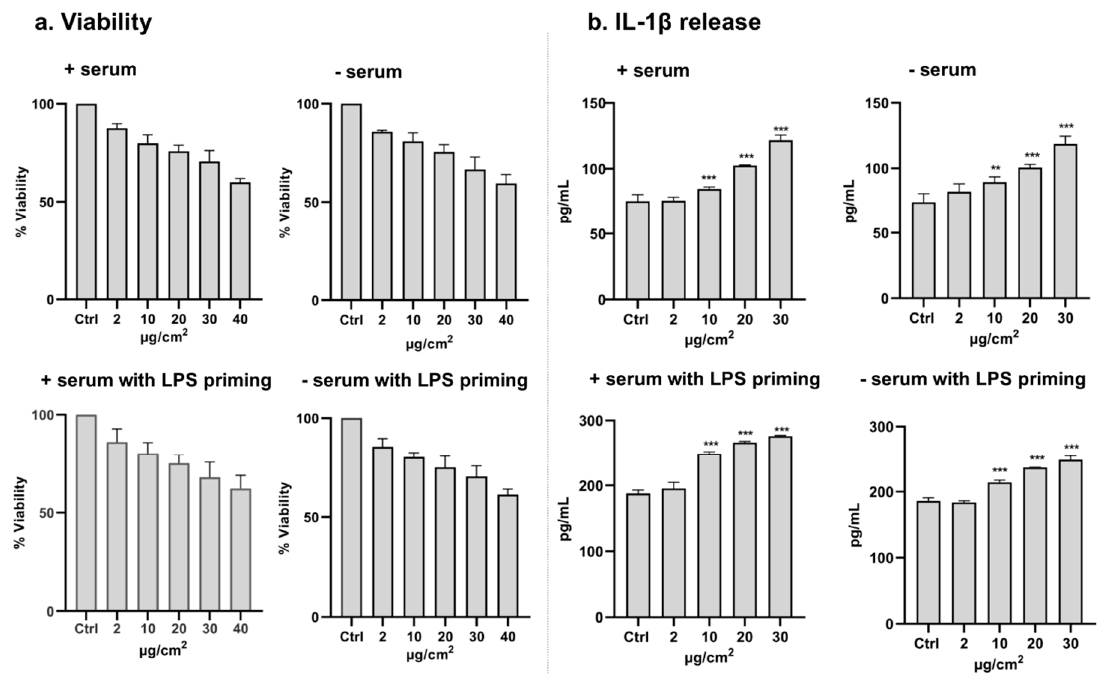
Figure 6. Cell viability ( a ) and IL-1 β release ( b ) after 24 h exposure of THP-1 (with or without priming using LPS, 100 ng/mL for 4 h) to CeO 2 NPs (nominal dose) in submerged conditions in media with or without serum. For viability, the bars represent mean ± SD from three independent experiments. All conditions caused a dose-dependent decrease in cell viability. For IL-1 β release, the bars represent mean ± SD from 4 wells in two different experiments. Significant results, as compared to control (Ctrl) are marked with asterisks (**for p < 0.001 and *** for p < 0.001).